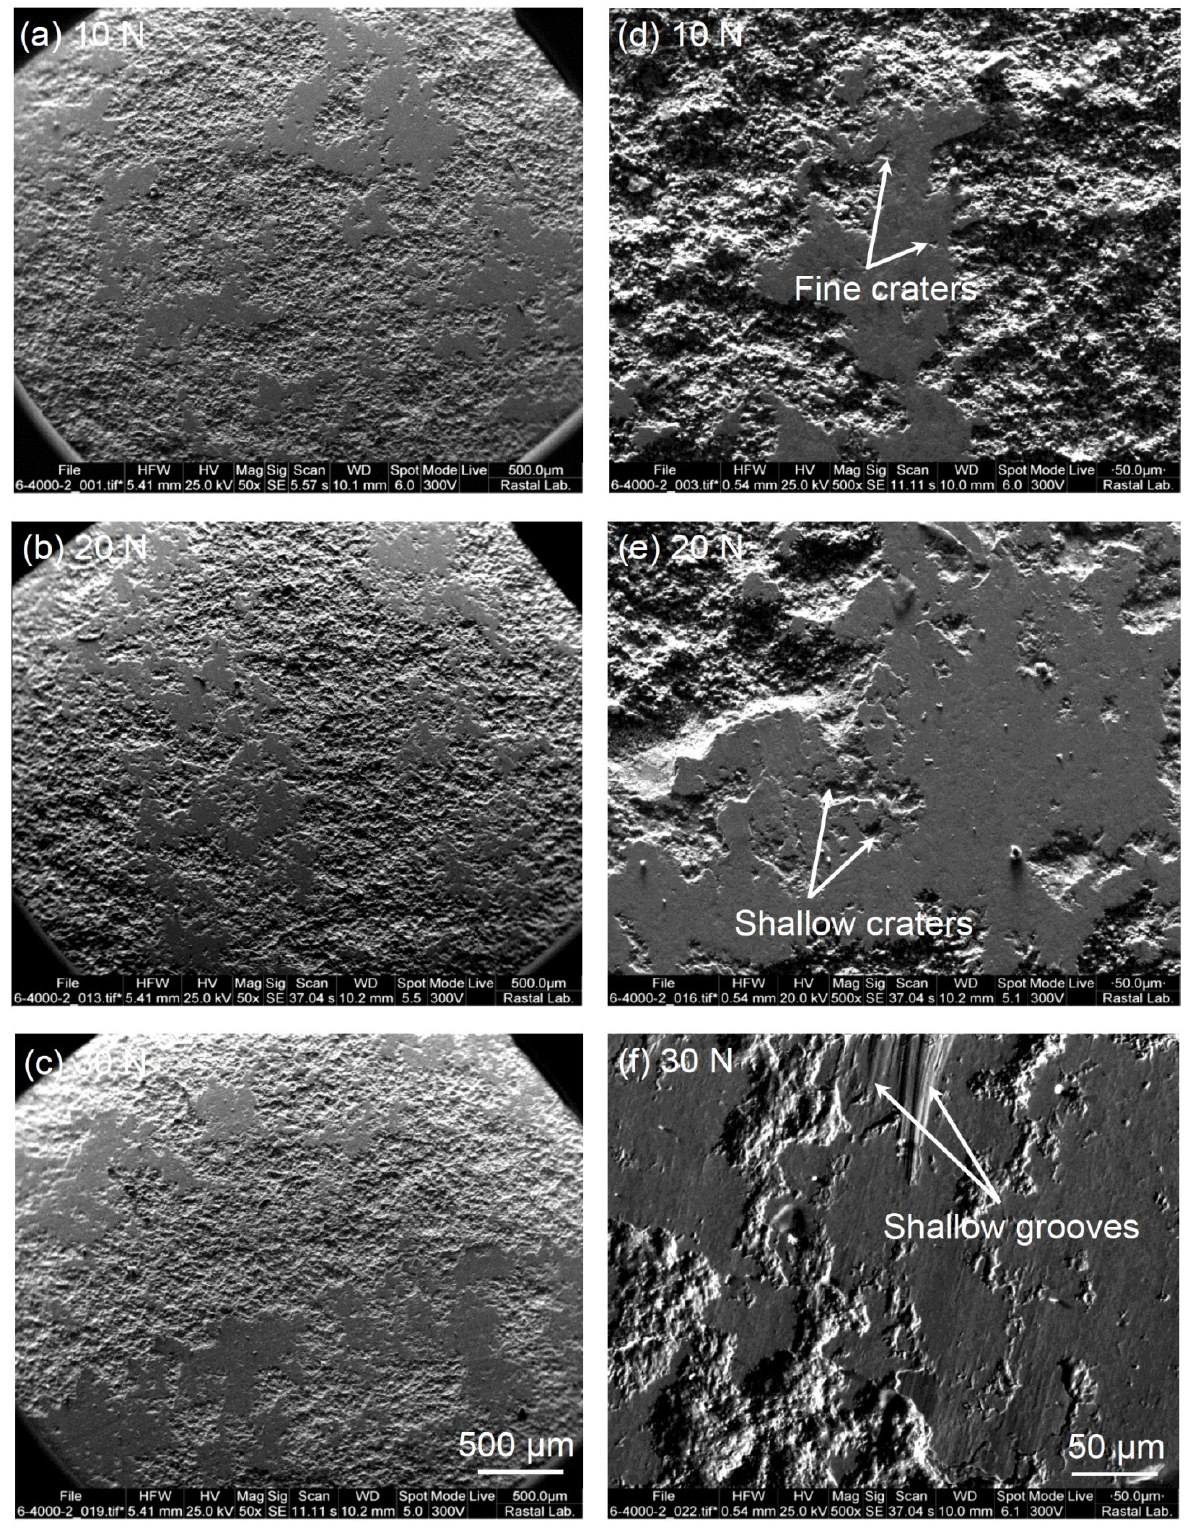
Figure 12. ( a – c ) Low and ( d – f ) high magnification SEM micrographs on worn surfaces of Cr 3 C 2 -NiCr coating under different applied loads.